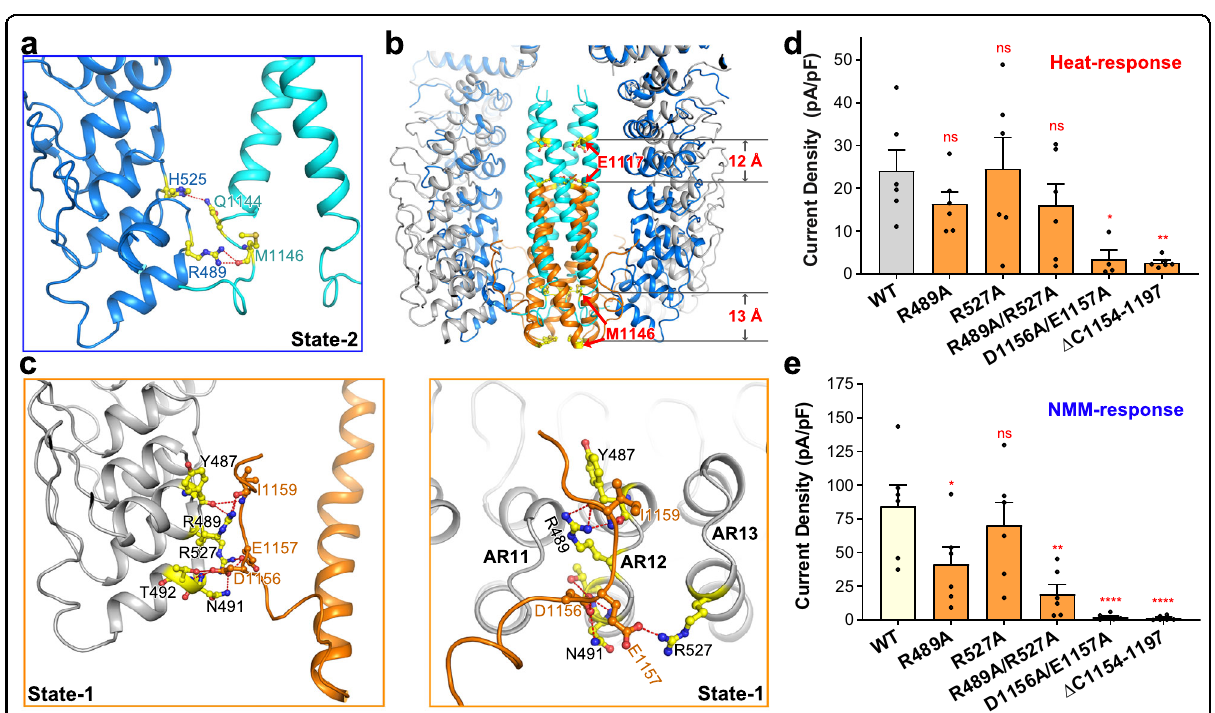
Fig. 4 The C-terminal coiled-coil domain of dTRPA1-A isoform undergoes a large movement during state transitions. a Interactions between the C-terminal coiled-coil domain and surrounding ARD in state-2 structure of dTRPA1-A isoform. The C-terminal coiled-coil domain and ARD of state-2 are coloured cyan and marine, respectively. b Compared with the state-2 structure, the coiled-coil domain has a large downward movement with ~12 – 13 Å in the state-1 structure. The C-terminal coiled-coil domain and ARD of state-1 are coloured orange and grey, respectively. c Interactions between the C-terminal coiled-coil domain and surrounding ARD in state-1 structure of dTRPA1-A isoform. Two views are shown here. d Heat-induced current densities for WT dTRPA1-A and the C-terminal mutants. Independent experiments were repeated for at least four times for each construct ( n = 6 for all, except D1156A/E1157A where n = 4). ns not signi fi cant, * P = 0.0267, and ** P = 0.0088 for WT versus mutants (one-way ANOVA with Dunnett ’ s multiple comparisons test). Data are mean ± s.e.m. e NMM-induced current densities at − 60 mV for WT dTRPA1-A and the C-terminal mutants. Independent experiments were repeated six times for each construct ( n = 6 for all). ns not signi fi cant, * P = 0.042, ** P = 0.0013 and **** P < 0.0001 for WT versus mutants (one-way ANOVA with Dunnett ’ s multiple comparisons test). Data are mean ± s.e.m. For d and e , the same values for the WT channel are used as in Fig. 3d, e for consistent comparison since all the electrophysiological data were acquired using the same batch of